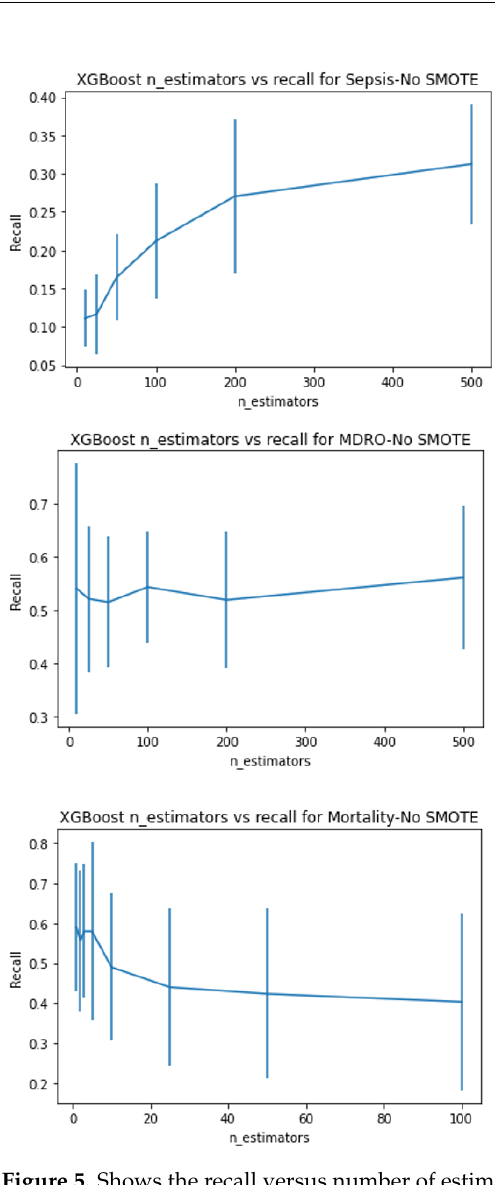
Figure 5. Shows the recall versus number of estimators for all three outcomes without data augmen- tation on the training set, plotted using XGboost as the base model.